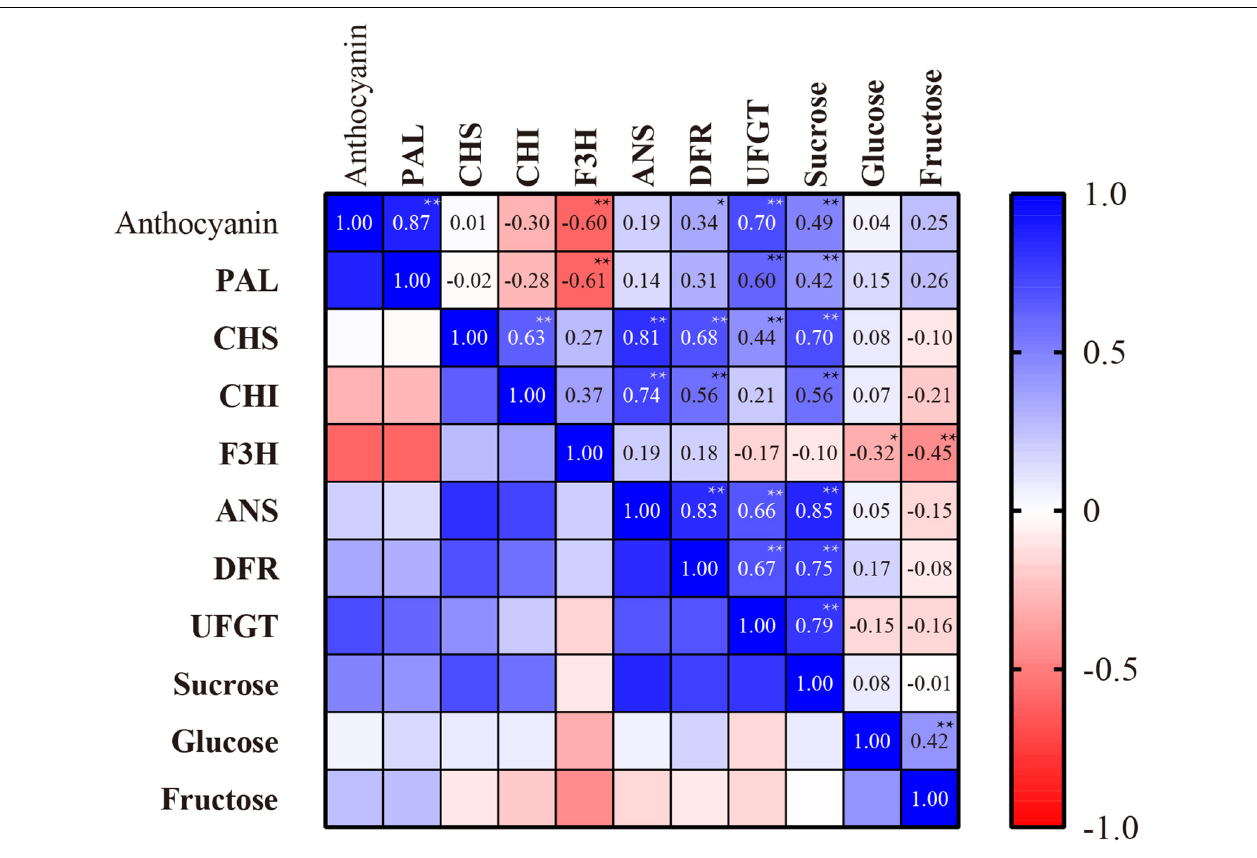
FIGURE 7 | Pearson’s correlation coefficients for the associations between anthocyanins content, anthocyanins biosynthesis enzyme activities, and sugar contents in peach skin exposed to MeJA and PDJ. *Significant at P < 0.05; **Significant at P <